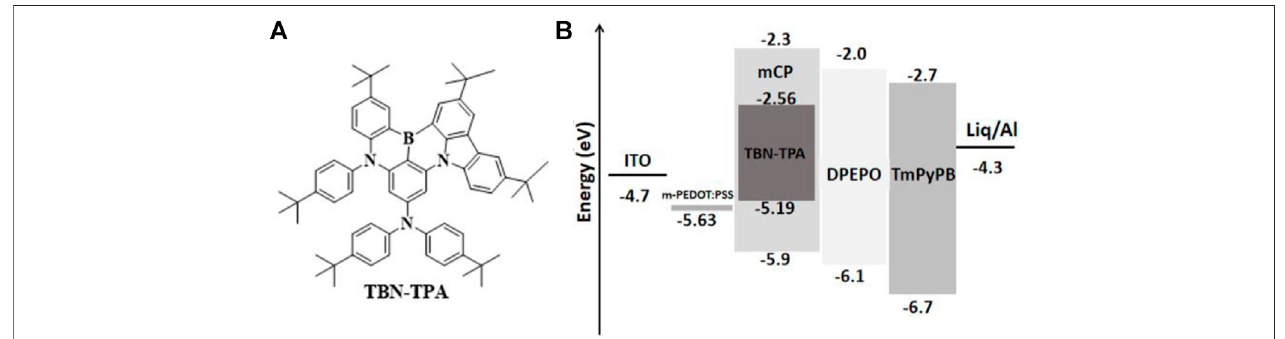
FIGURE 1 | (A) The chemical structure of TBN-TPA. (B) Energy level diagrams of the